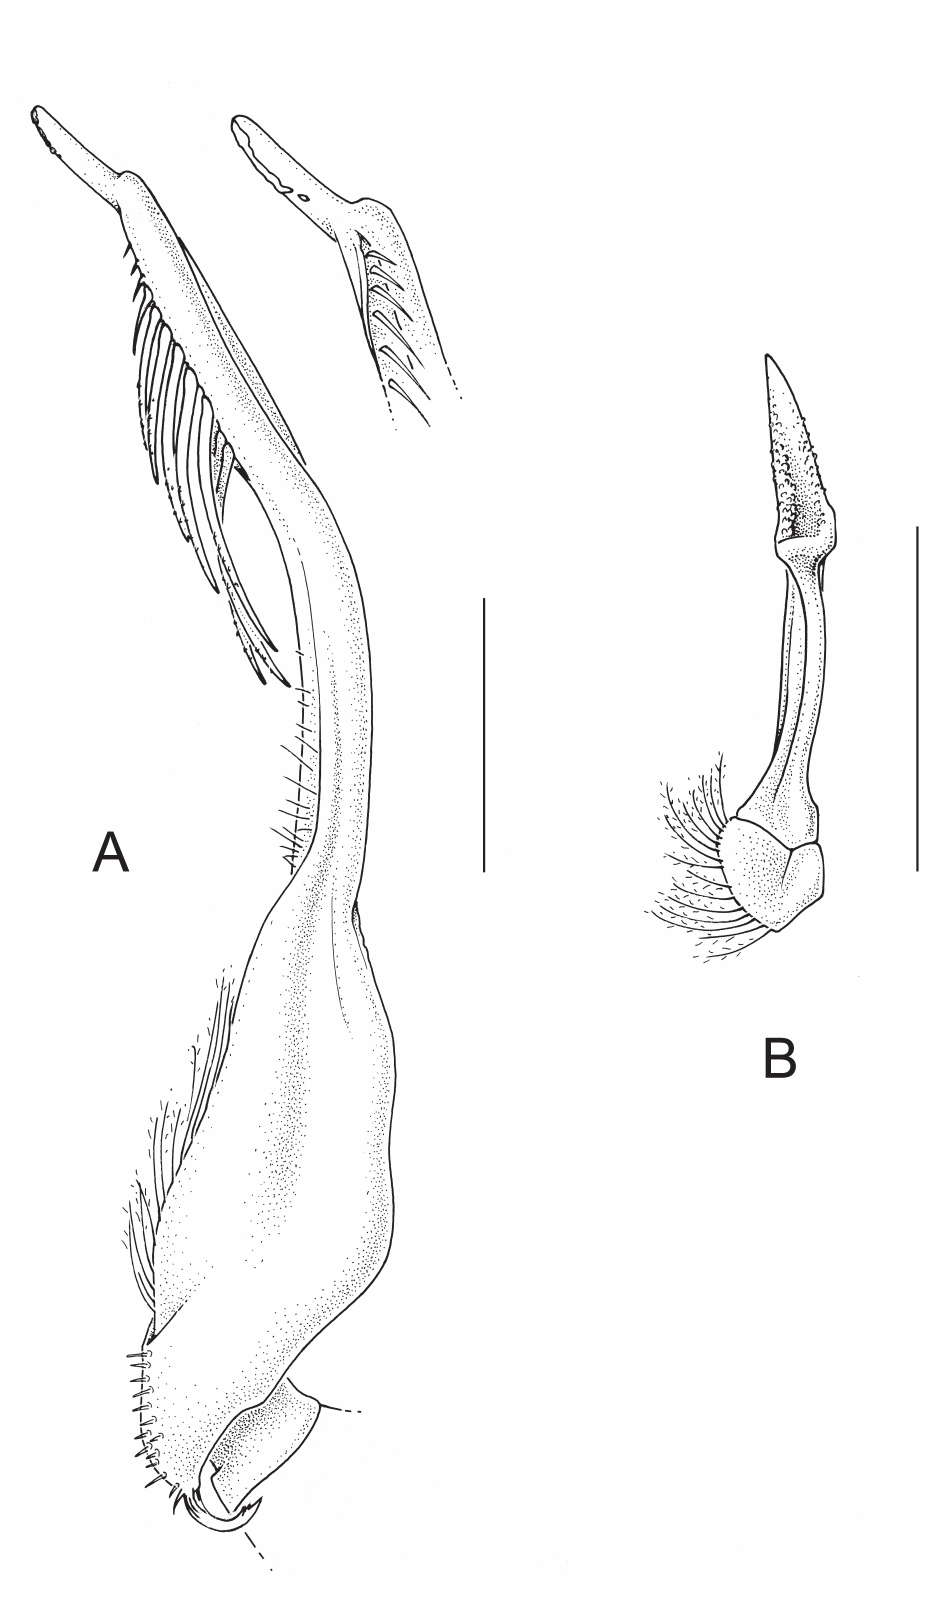
Fig. 3. Praebebalia fungifera sp. nov., holotype, ♂ ( 8.8 mm) (MNHN-IU-2013-5996). A . Left G1 (ventral view), distal part of left G1 (dorsal view). B . Left G2. Scales: A–B = 1.0